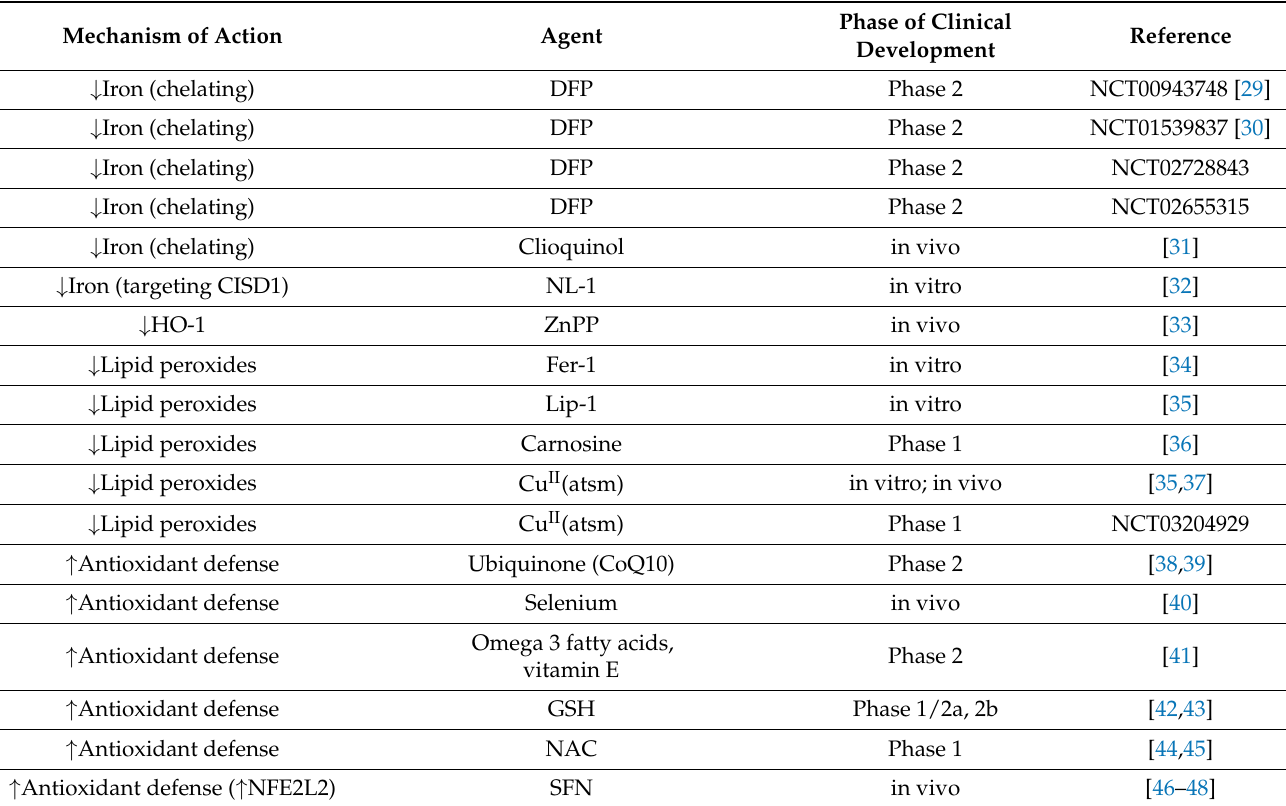
Table 2. Updated therapeutic approaches targeting ferroptosis pathways in neuroinflammation and PD. Mechanism of Action